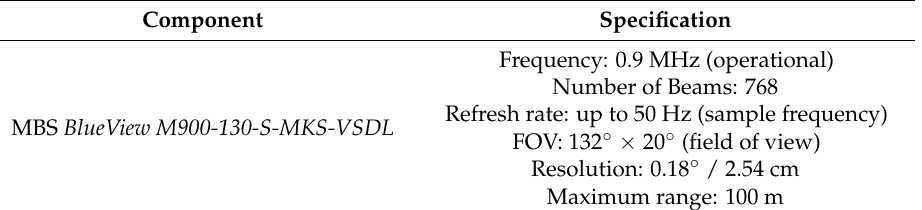
Table 1. Technical specifications of the multibeam imaging sonar used in this